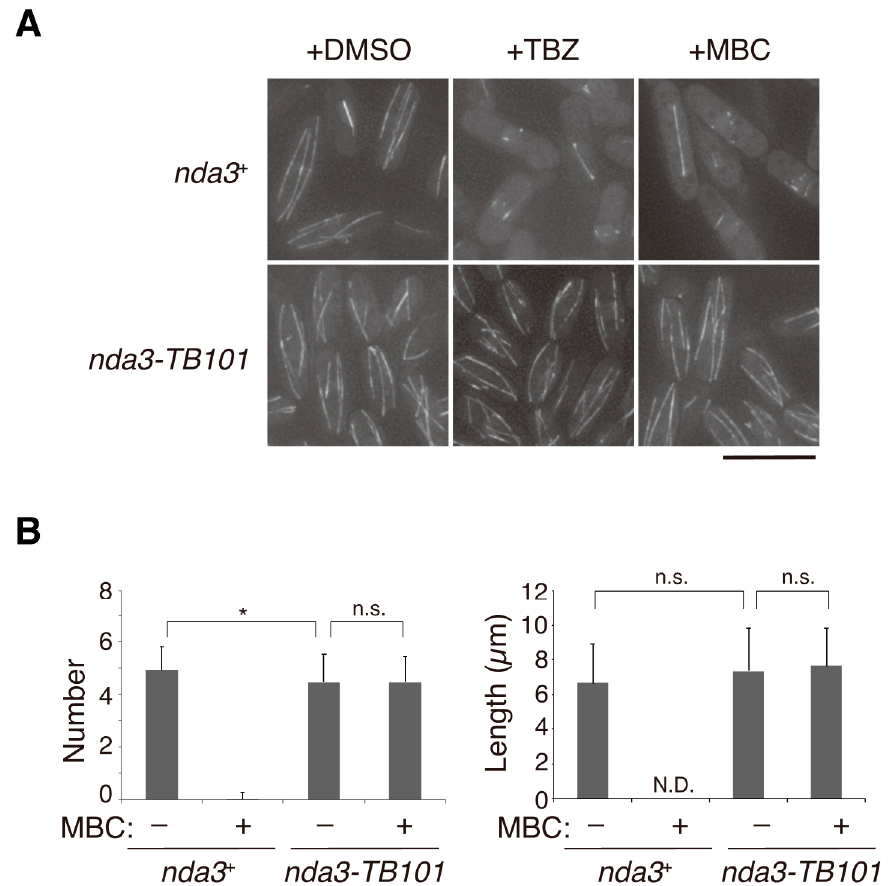
Figure 3. Microtubules in nda3-TB101 cells are unaffected by microtubule poisons. ( A ) WT ( nda3 + ) and nda3-TB101 cells expressing GFP-Atb2 ( α 2-tubulin) were grown and observed in the presence of DMSO (control), TBZ, and MBC (50 µ g/mL each). Scale bar, 10 µ m. ( B ) The numbers of cytoplasmic microtubules per cell (left, n = 50 cells) and the length of each microtubule bundle (right, n = 50 bundles) in WT and nda3-TB101 cells were measured in the absence or presence of MBC (50 µ g/mL). N.D., not determined; n.s., not significant; * p = 0.021 < 0.05 (Student’s t -test); error bars = S.D.